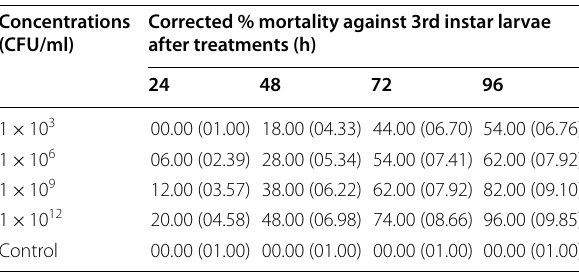
Figures in parentheses are transformed values (arc sine transformation) CD ( P 0.05) =